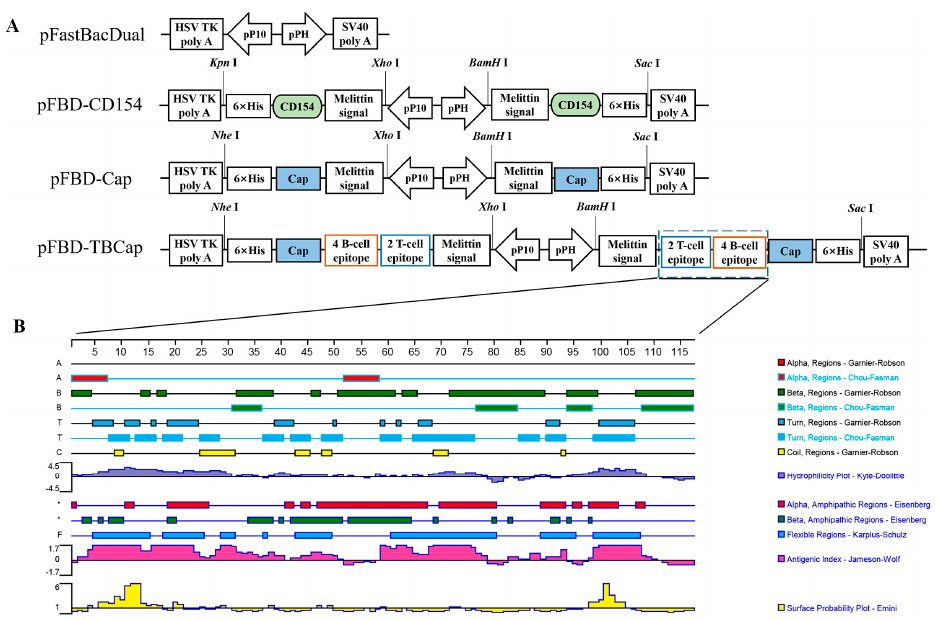
Figure 1. Construction of shuttle plasmids and prediction of antigenic epitope structures. ( A ) Sche- matic diagram of the shuttle plasmid construction. ( B ) Secondary structure prediction of dominant antigenic epitope peptides.